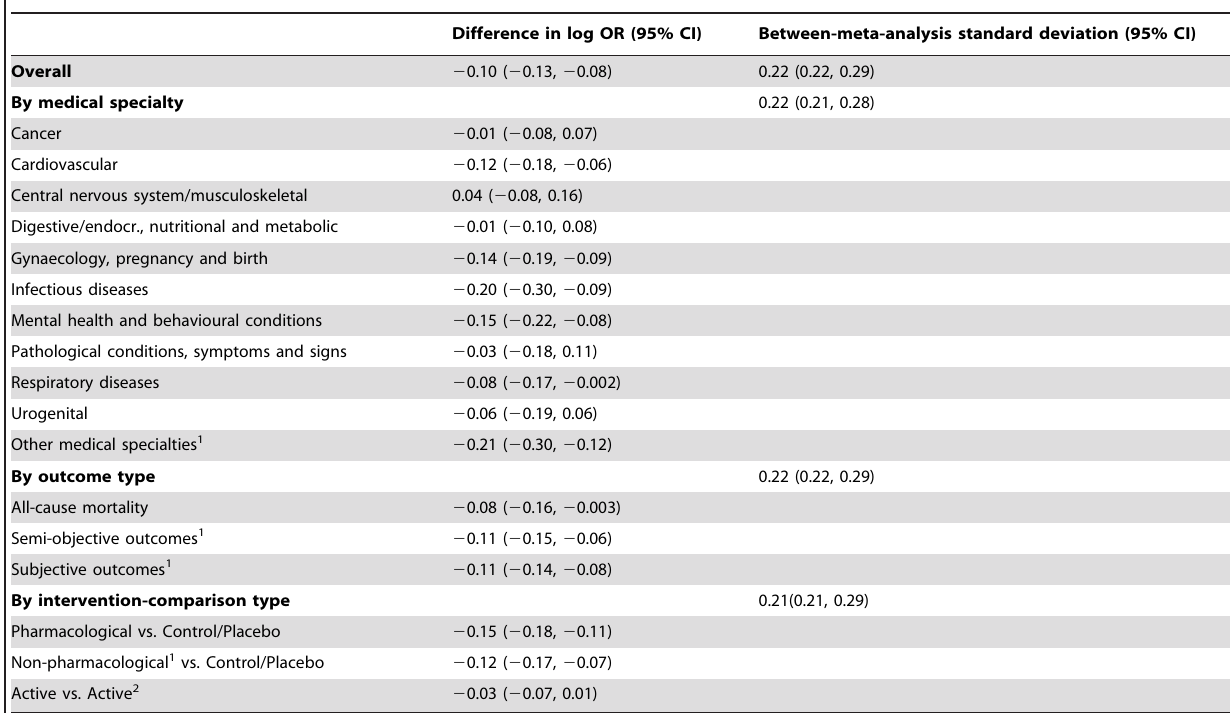
Table 5. Average differences in observed log odds ratios between underpowered ( Power RRR 30 v 50% ) compared to adequately powered studies, in subset A of 1,107 meta-analyses, overall and within medical specialties, outcome types and intervention- comparison